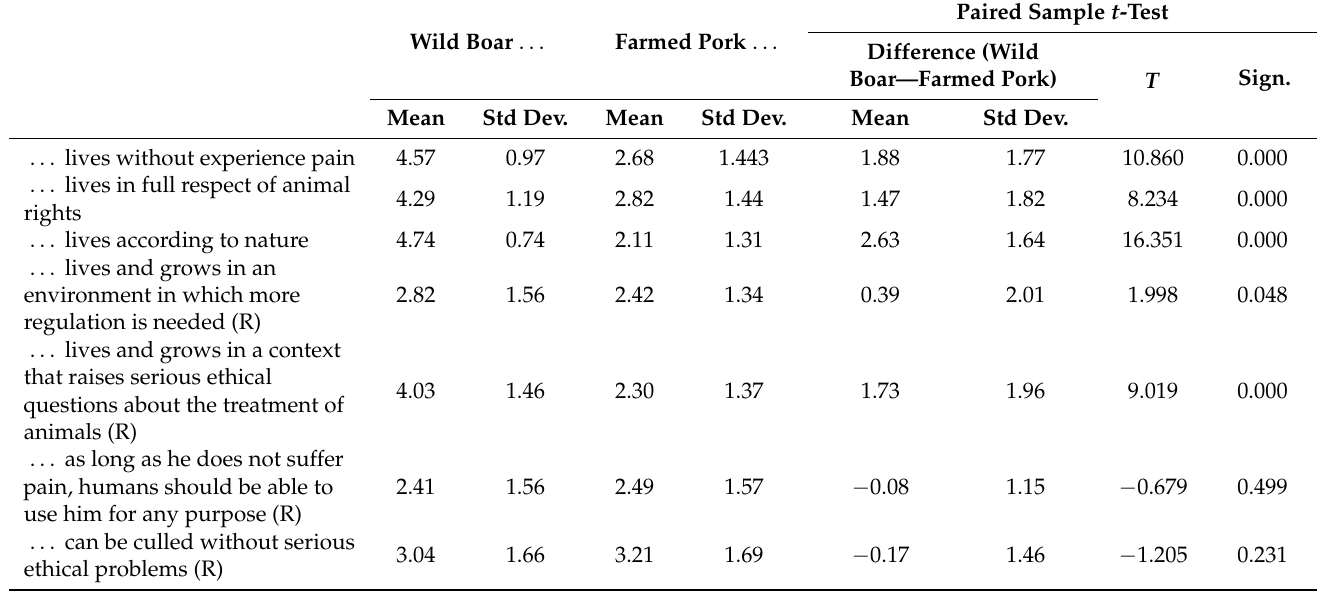
Table 3. Animal growth—Wild-life vs. Breeding.